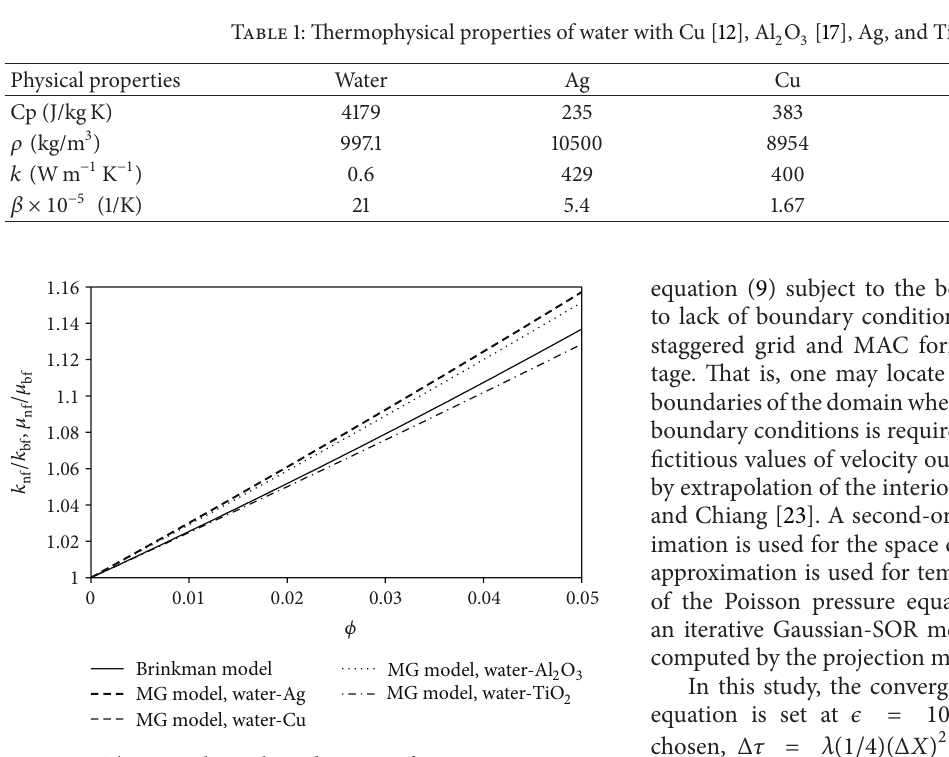
Figure 2: The ratio thermal conductivity of water-Ag, water-Cu, water-Al 2 O 3 , and water-TiO 2 using Maxwell-Garnett model and the ratio dynamical viscosity using Brinkman model versus volume